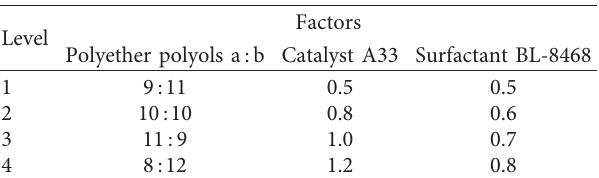
Table 2: Orthogonal test scheme of three factors and four levels